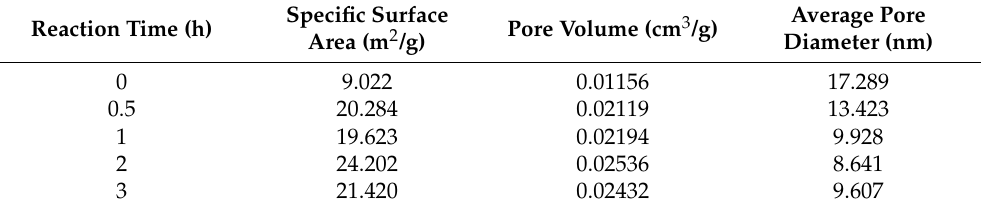
Table 1. Micropore parameters of coke and CO 2 under different melting-loss